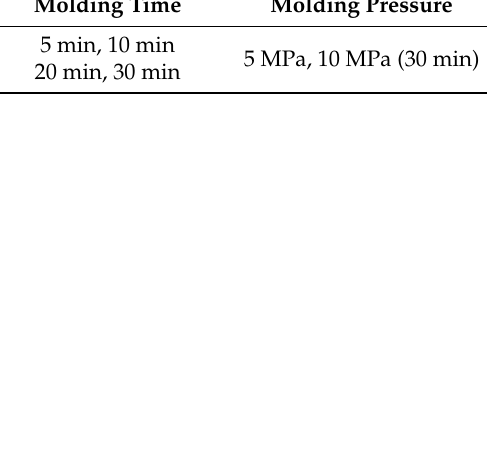
Figure 5. Profile of molding pressure and molding temperature.